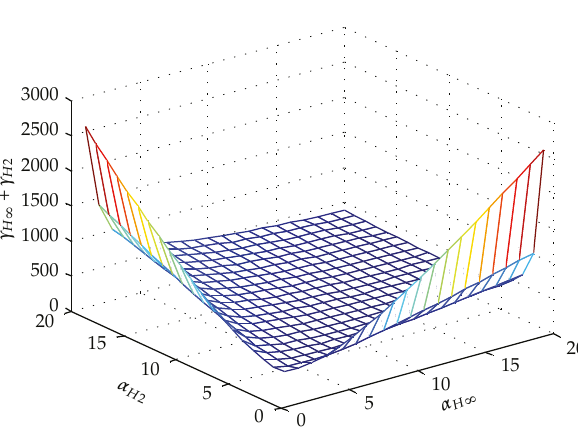
Figure 1: 3D-plot of the waveform γ H 2 (cid:9) γ H ∞ in the plane (cid:7) α H 2 ,α H ∞ (cid:8)